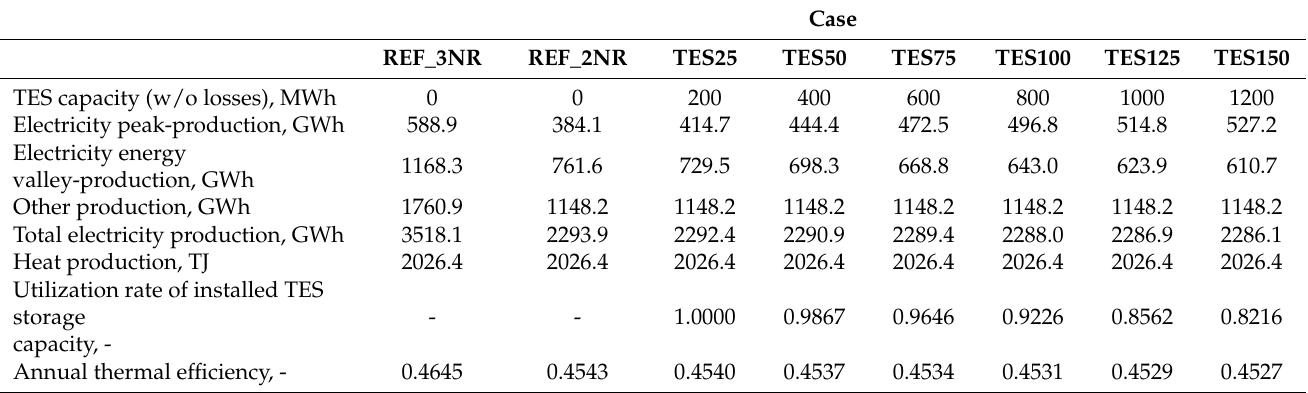
Table 3. Results of technical assessment of respective analyzed cases of nuclear